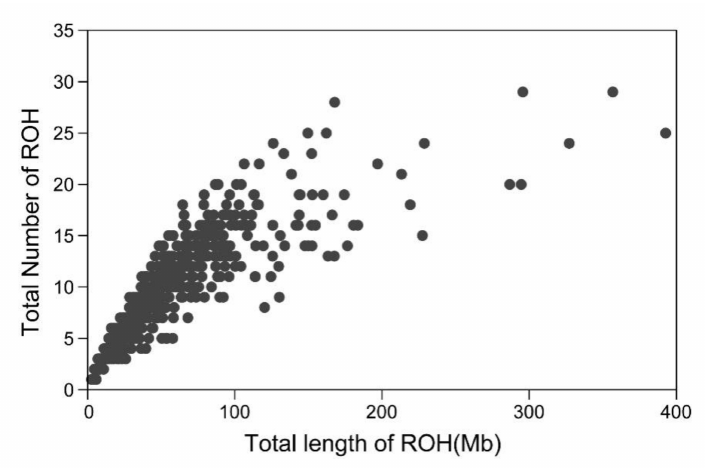
Figure 1. Total number of runs of homozygosity (ROH) exceeding 1 Mb and total length of genome (in Mb) covered by ROH segments in Chinese Merino.